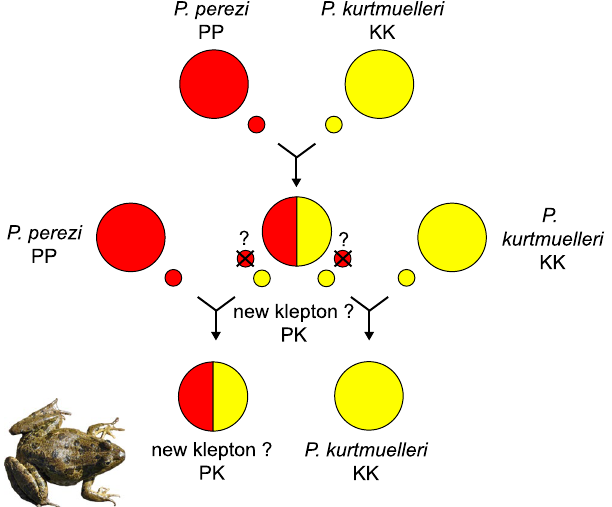
Figure 4. Hypothesis of a new Pelophylax hybridogenetic complex in southern France. Large circles illustrate genomes; small circles illustrate gametes. Crosses between P. perezi and P. kurtmuelleri would form a new klepton. As their P. perezi germline might be eliminated (as in the P . kl grafi complex), kleptons may only produce P. kurtmuelleri offspring (when mating with P. kurtmuelleri ) or P. kurtmuelleri × P. perezi